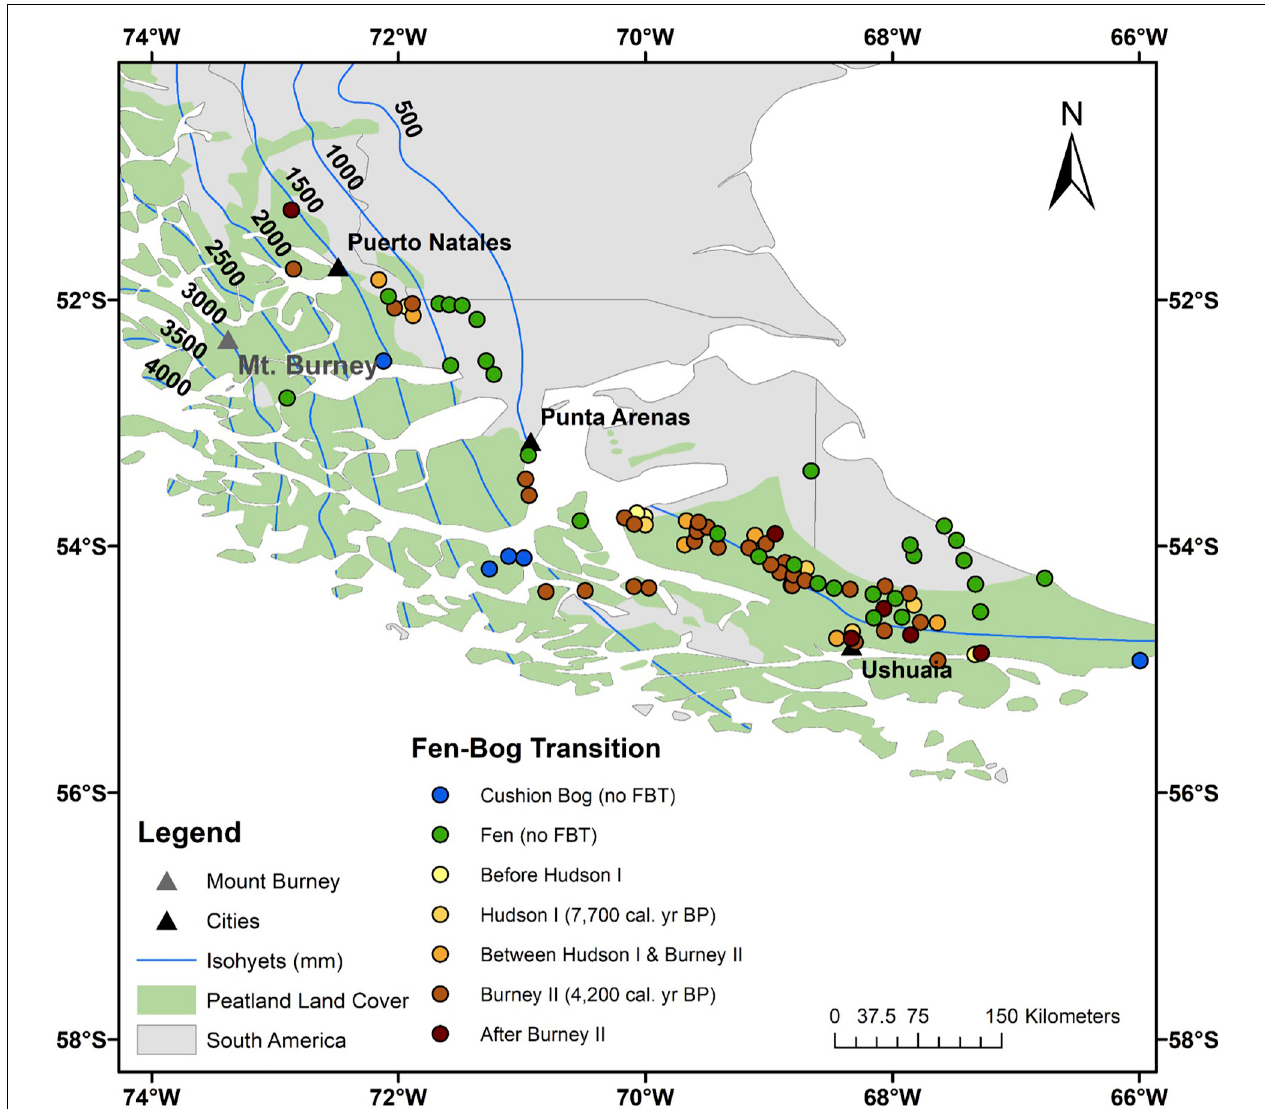
FIGURE 4 | Fen-bog transition timing across southern South America. Non- Sphagnum peatlands (fens and cushion bogs) are also shown. The location of Mount Burney is indicated by a gray triangle. Mount Hudson (45.9 S, 72.97 W) is located outside the area shown on the map. The peatland area is from Yu et al. (2010) and the dataset used to generate the isohyets is from New et al.